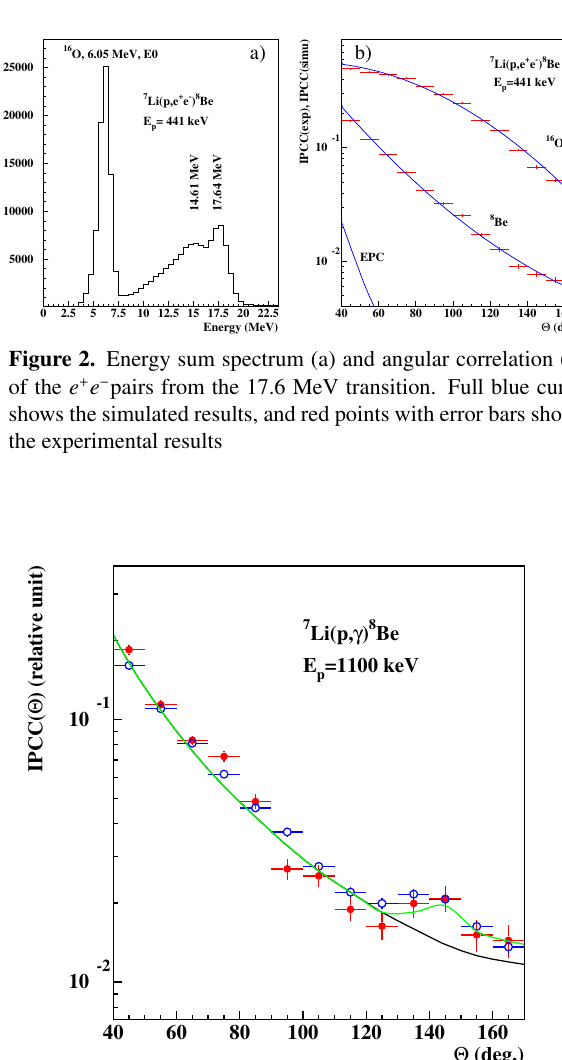
where N bk g d and N si g are the number of background and signal events,